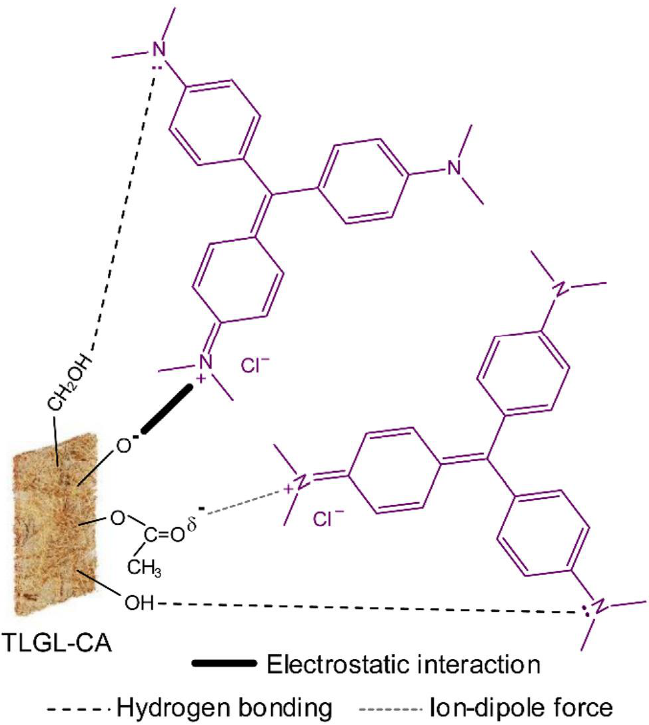
Figure 8. Proposed adsorption mechanism of crystal violet on lemongrass leaf fibers incorporated with cellulose acetate. Reprinted from ref. [130] with permission. Table 5. Adsorption of dyes over different